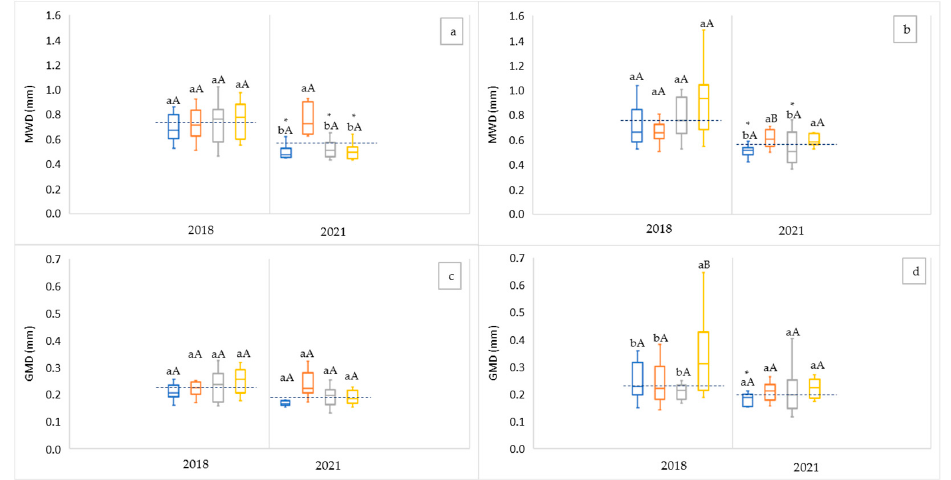
Figure 5. Mean weight diameter (MWD) and geometric mean diameter (GMD), for conventional- tillage (CT; blue bars); saffron (D-S; orange bars); oats (D-O; grey bars) and lavender (D-L; yellow bars) treatments at ( a ) 0–10 cm depth, ( b ) 10–30 cm depth, ( c ) 0–10 cm depth and ( d ) 10–30 cm depth. The different lowercase letters above the error bars for the same soil layer indicate significant differences between managements at p < 0.05. Different capital letters are indicating differences in depth. Each cultivation system (*) represents significant differences with respect to the olive monocrop conventional tillage system in 2018 (control treatment) by Dunnett’s test ( p < 0.001). Missing asterisks denote non-significant differences. Table 1. GMD sensitivity index (SI GMD ) in the 0–10, and 10–30 cm layers.